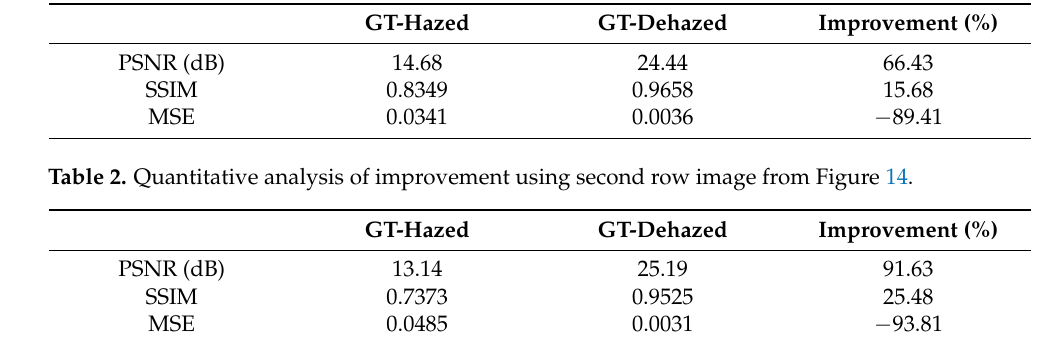
Table 2. Quantitative analysis of improvement using second row image from Figure 14 Table 1. Quantitative analysis of improvement using first row image from Figure 14.